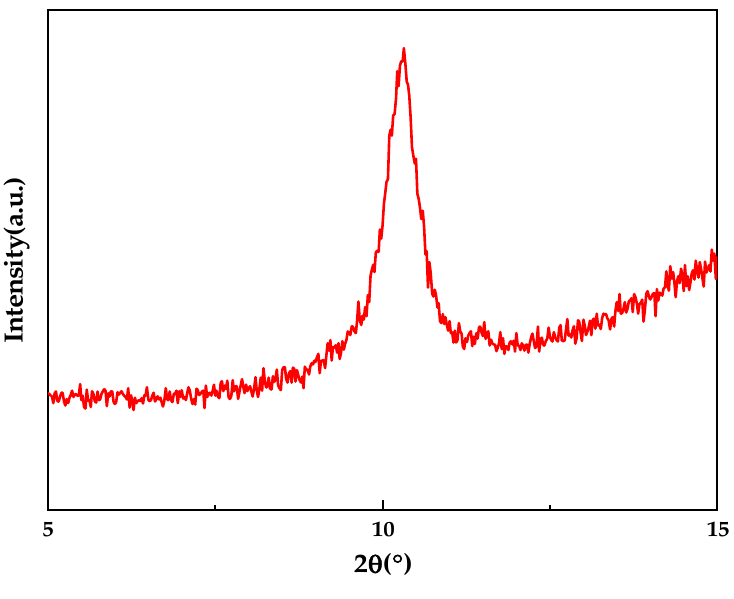
Figure 2. XRD spectrum of GO. Secondly, to characterize the thermal stability of the GO material, DSC measurements were performed. Figure 3 shows the DSC curves from the thermogravimetric analysis of GO. A clear peak of heat absorption was observed on the DSC curve at around 190 °C, which is consistent with that reported in the literature. However, the weight loss peak did not appear again at around 300 °C, which may be caused by the rapid evaporation of a large amount of water present between the GO sheets.